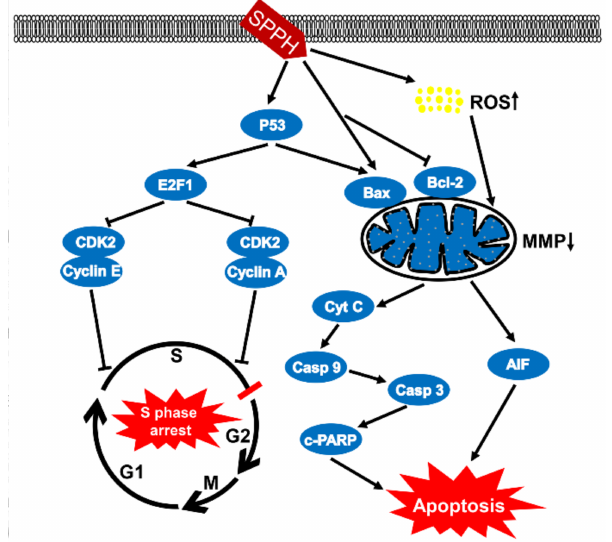
Figure 6. Proposed model for the mechanisms of SPPH-induced cytotoxicity in SGC-7901 cells. On the one hand, SPPH enhanced P53 expression to induce E2F1 and suppressed two complexes of CDK2 and Cyclin E, CDK2 and Cyclin A, which blocked the cell cycle in S phase. On the other hand, SPPH promoted ROS accumulation and induced the expression of Bax by enhancing the expression of P53, or induced Bax expression, inhibited Bcl-2 expression independently, destroyed MMP and induced Cyt C and AIF release to activate downstream caspase signal pathways and apoptosis. Casp 9, caspase-9; Casp 3, caspase-3; c-PARP, cleaved